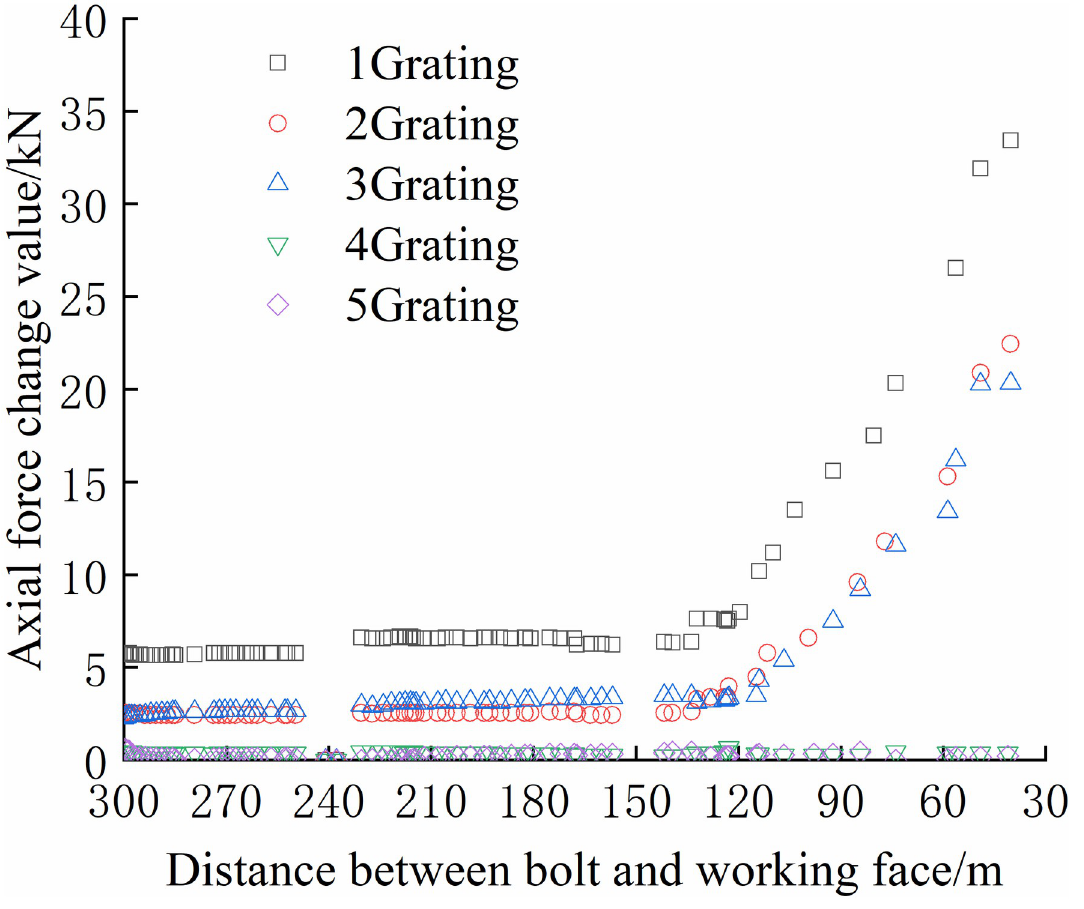
Fig 27. Axial stress monitoring test curve of No.4 bolt.